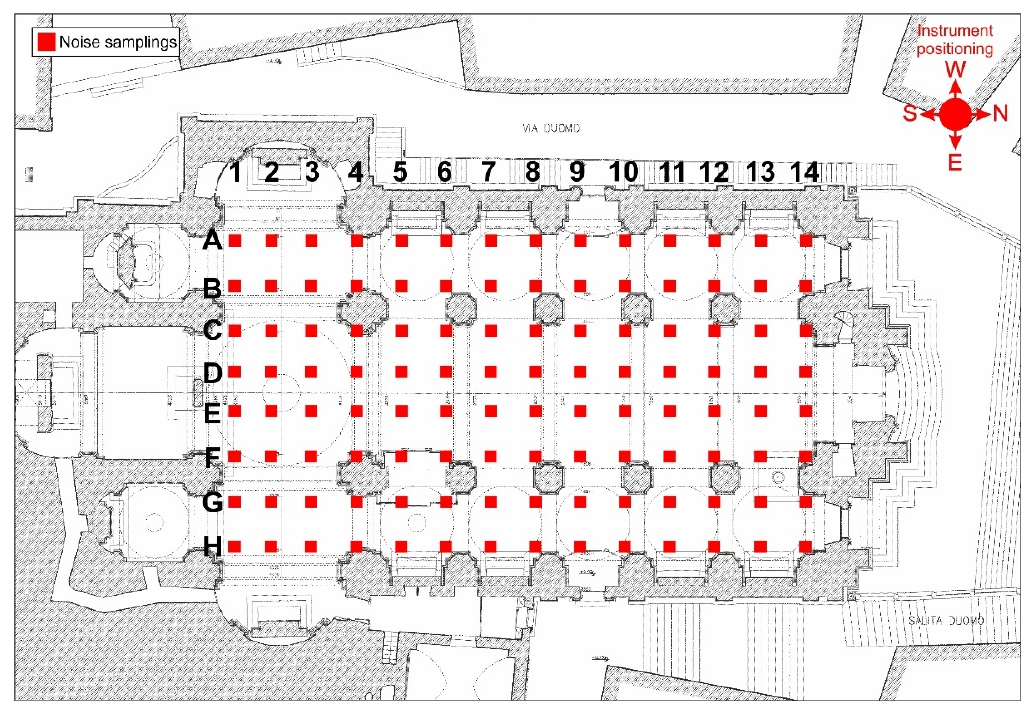
Figure 7. Locations of ambient noise samplings.